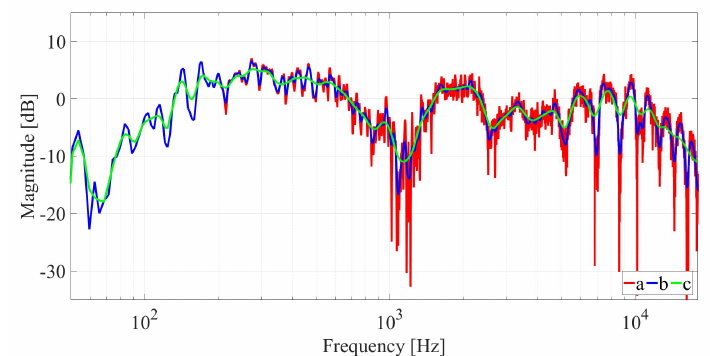
Figure 4. Complex smoothing of a measured room transfer function (RTF): ( a ) RTF; ( b ) 1/12 octave-band complex smoothing; ( c ) 1/3 octave-band complex